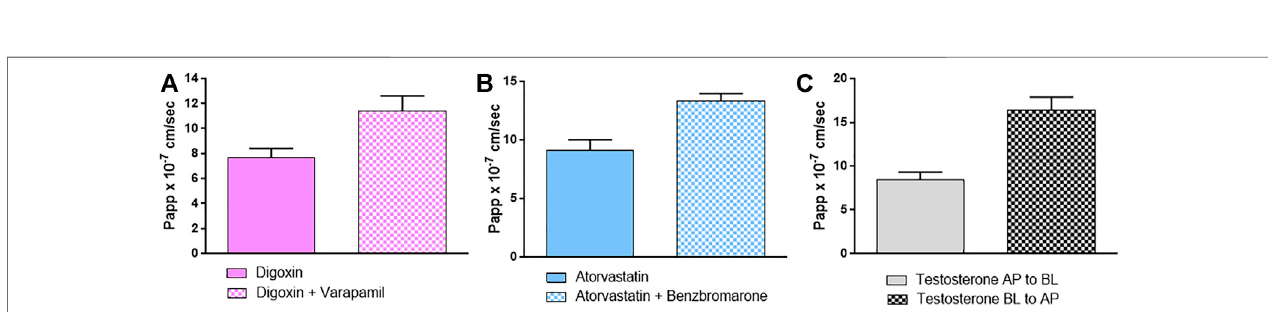
FIGURE 3 | Papp (AP-BL) values of speci fi c probe substrates with and without speci fi c inhibitors (A) digoxin/verapamil (B) atorvastatin/benzbromarone as substrate/inhibitor of P-gp and MRP respectively and (C) Papp (AP-BL) and (BL-AP) of testosterone used as BCRP probe substrate. Details are given in M&M. Results are expressed as means ± standard